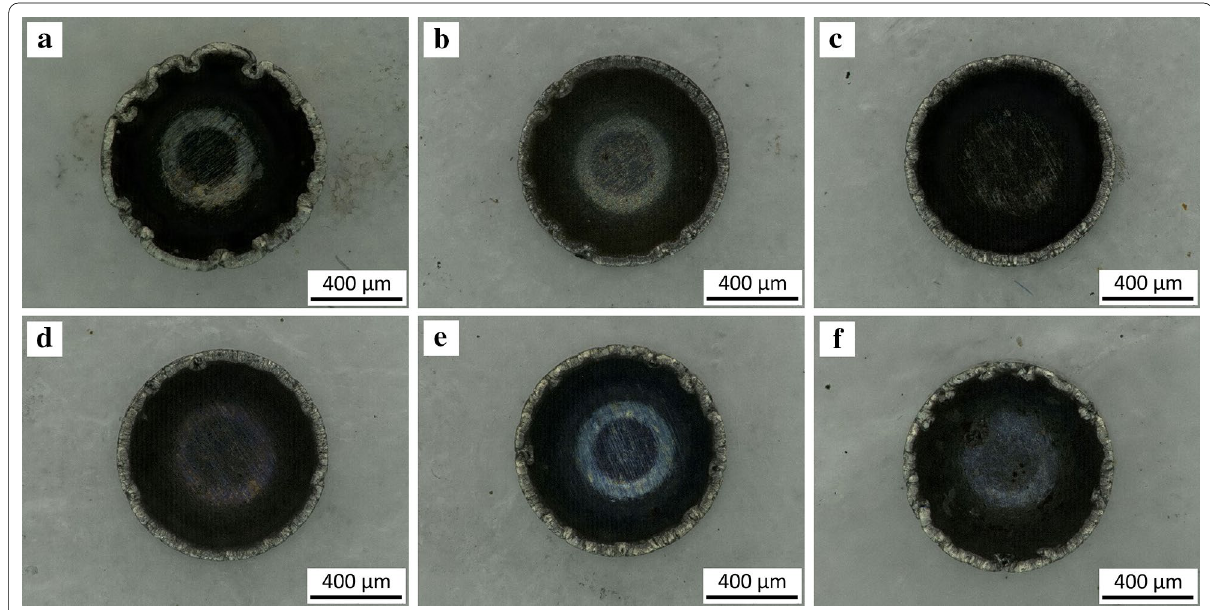
Figure 8 Top views of the drawn cups with annealed specimens: a A700, b A850, c A900, d A950, e A1000, f